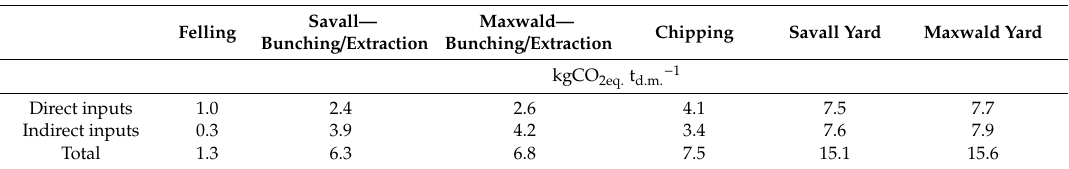
Table 14. Total emission in forestry logging yards, for single operation and yard, reported in CO 2 equivalent, shared in direct and indirect process.